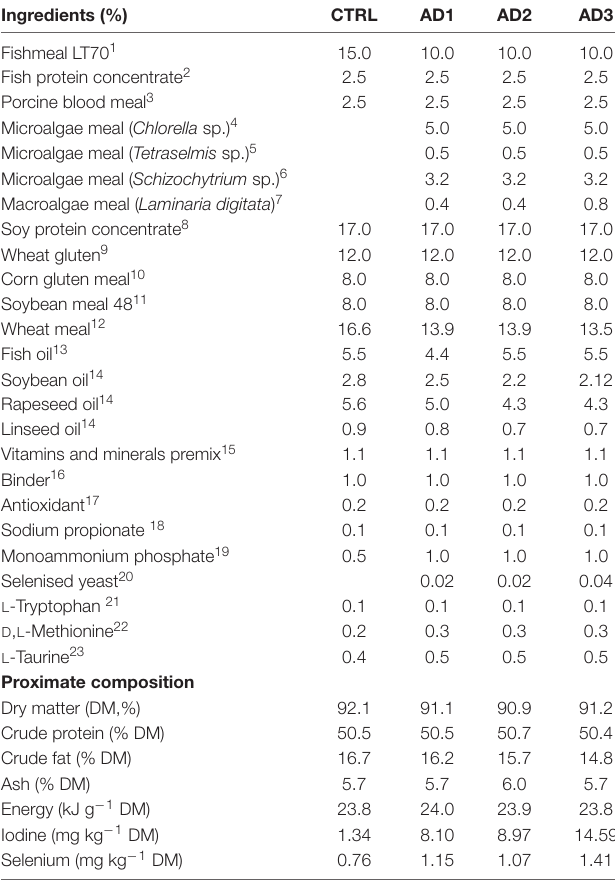
TABLE 1 | Ingredients and proximate composition of the experimental